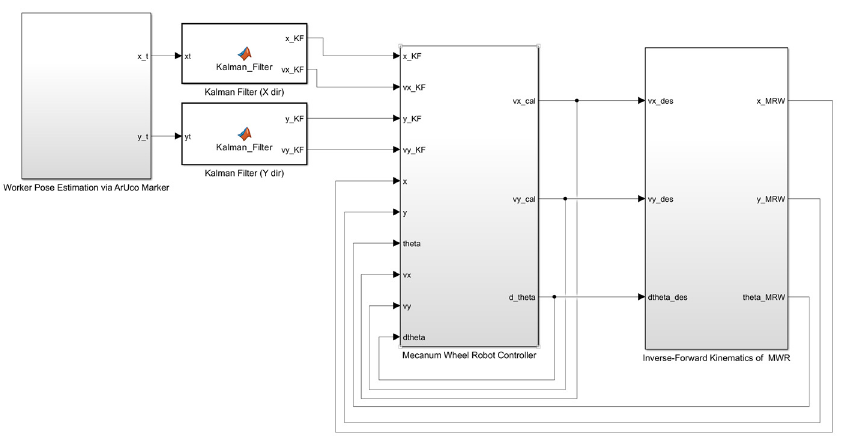
Figure 6. The control structure of a worker-following robot.